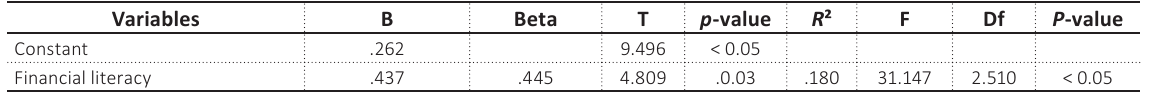
Table 3. Financial literacy as a predictor of business risk-taking Variables B Beta